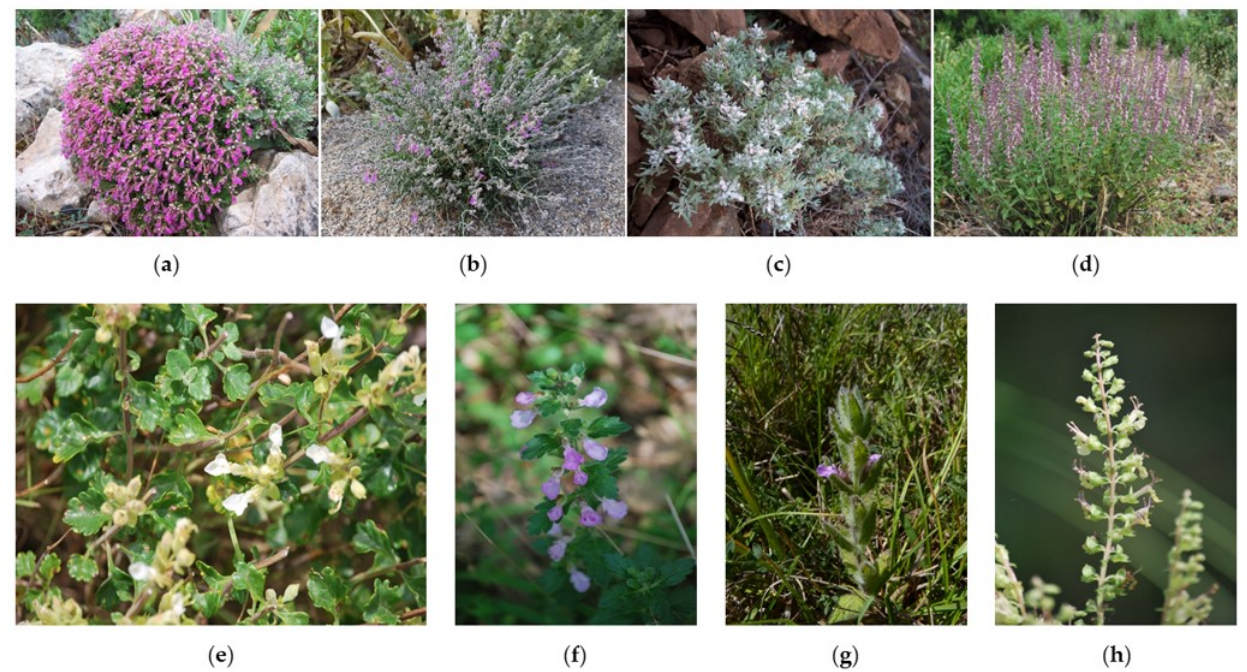
Figure 1. Teucrium taxa selected for this study: ( a ) T. marum ; ( b ) T. subspinosum ; ( c ) T. capitatum subsp. capitatum ; ( d ) T. massiliense ; ( e ) T. flavum subsp. glaucum ; ( f ) T. chamaedrys subsp. chamaedrys ; ( g ) T. scordium subsp. scordioides ; ( h ) T. scorodonia